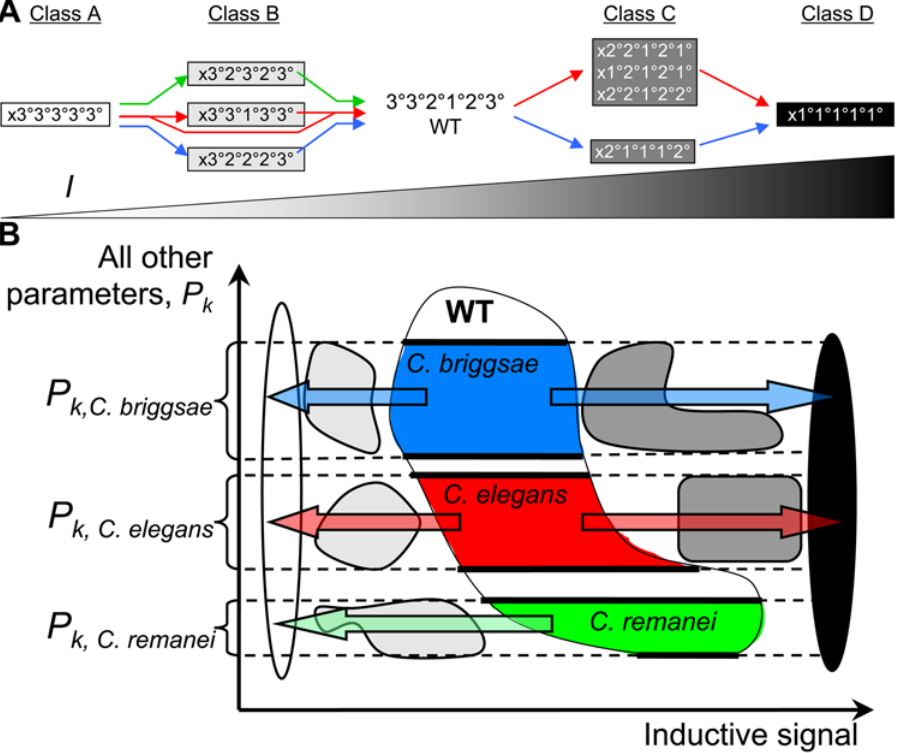
Figure6. (A) Summary ofexperimentally observedphenotypes in three differentspecies ofthe Caenorhabditis genus. Distinctphenotypes have been reported upon increasing or decreasing the level of inductive signal ( I ) in three major members of the Caenorhabditis genus [22]. The wild-type phenotype (center) is commonto all three species. The colored lines denote the species-specific progression of phenotypes asthe level of inductivesignal ( I ) is modulated in C. elegans (red), C. briggsae (blue) and C. remanei (green). Phenotypes were not reported in C. remanei upon increasing inductive signal above the wild-type level [22]; therefore, green arrows are not drawn to the right of the wild-type phenotype. The phenotypes are grouped into Classes A, B, C, and D and are shaded (white, light grey, dark grey and black) accordingto the amount of perturbation in inductive signal that rendered each mutant. In some species the first pre-cursor cell (P3.p) is not competent to participate in vulval development, and therefore, it is designated as ‘x’. (B) The quantitative diversification hypothesis. Species belonging to the Caenorhabditis genus all produce a common wild-type phenotype using a common regulatory network that performs with quantitative differences in parameter settings. Thus, C. elegans (red), C. briggsae (blue) and C. remanei (green) are hypothesized to occupy different subspaces within the wild-type parameter space. This quantitative diversification has been proposed to explain the fact that changes in the level of inductive signal produce species-specific mutant phenotypes.